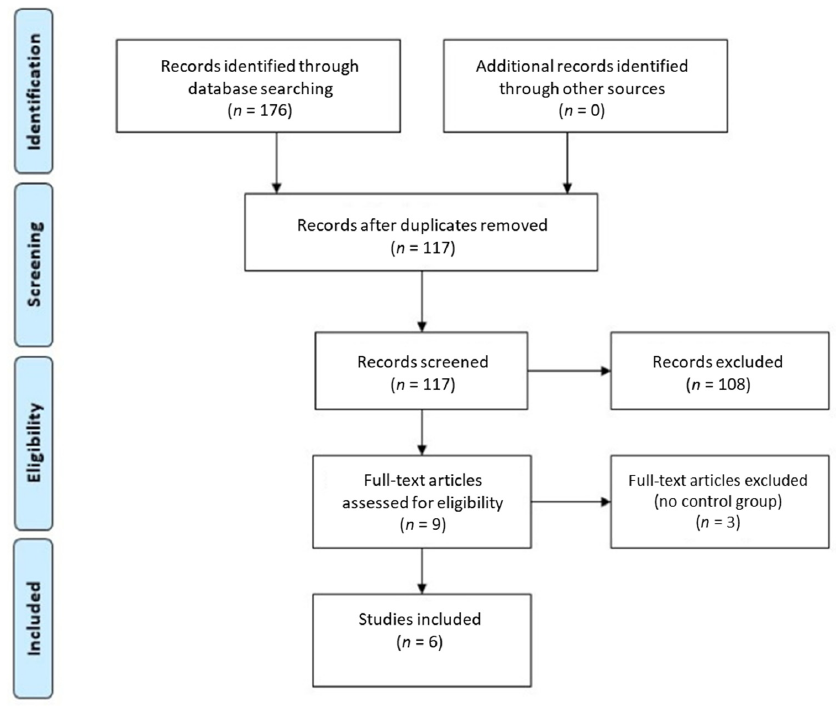
Figure 1. The review search and selection flowchart. Table 1. Studies characteristics and